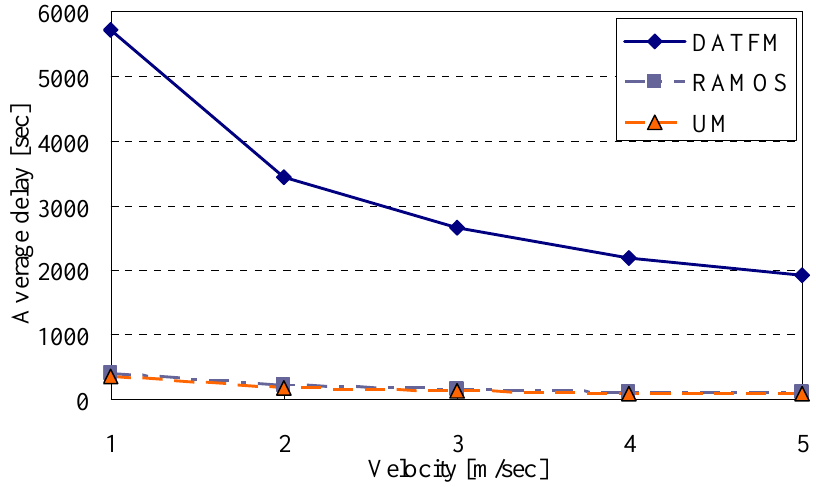
Figure 13. Velocity and average